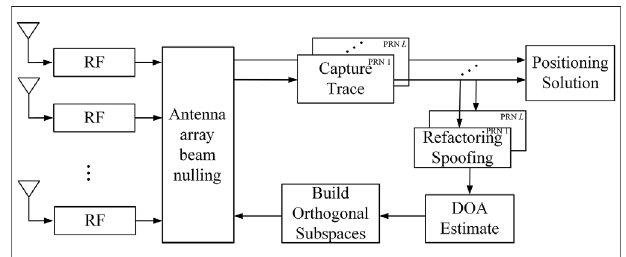
FIGURE 8 | Schematic diagram of the algorithm structure.